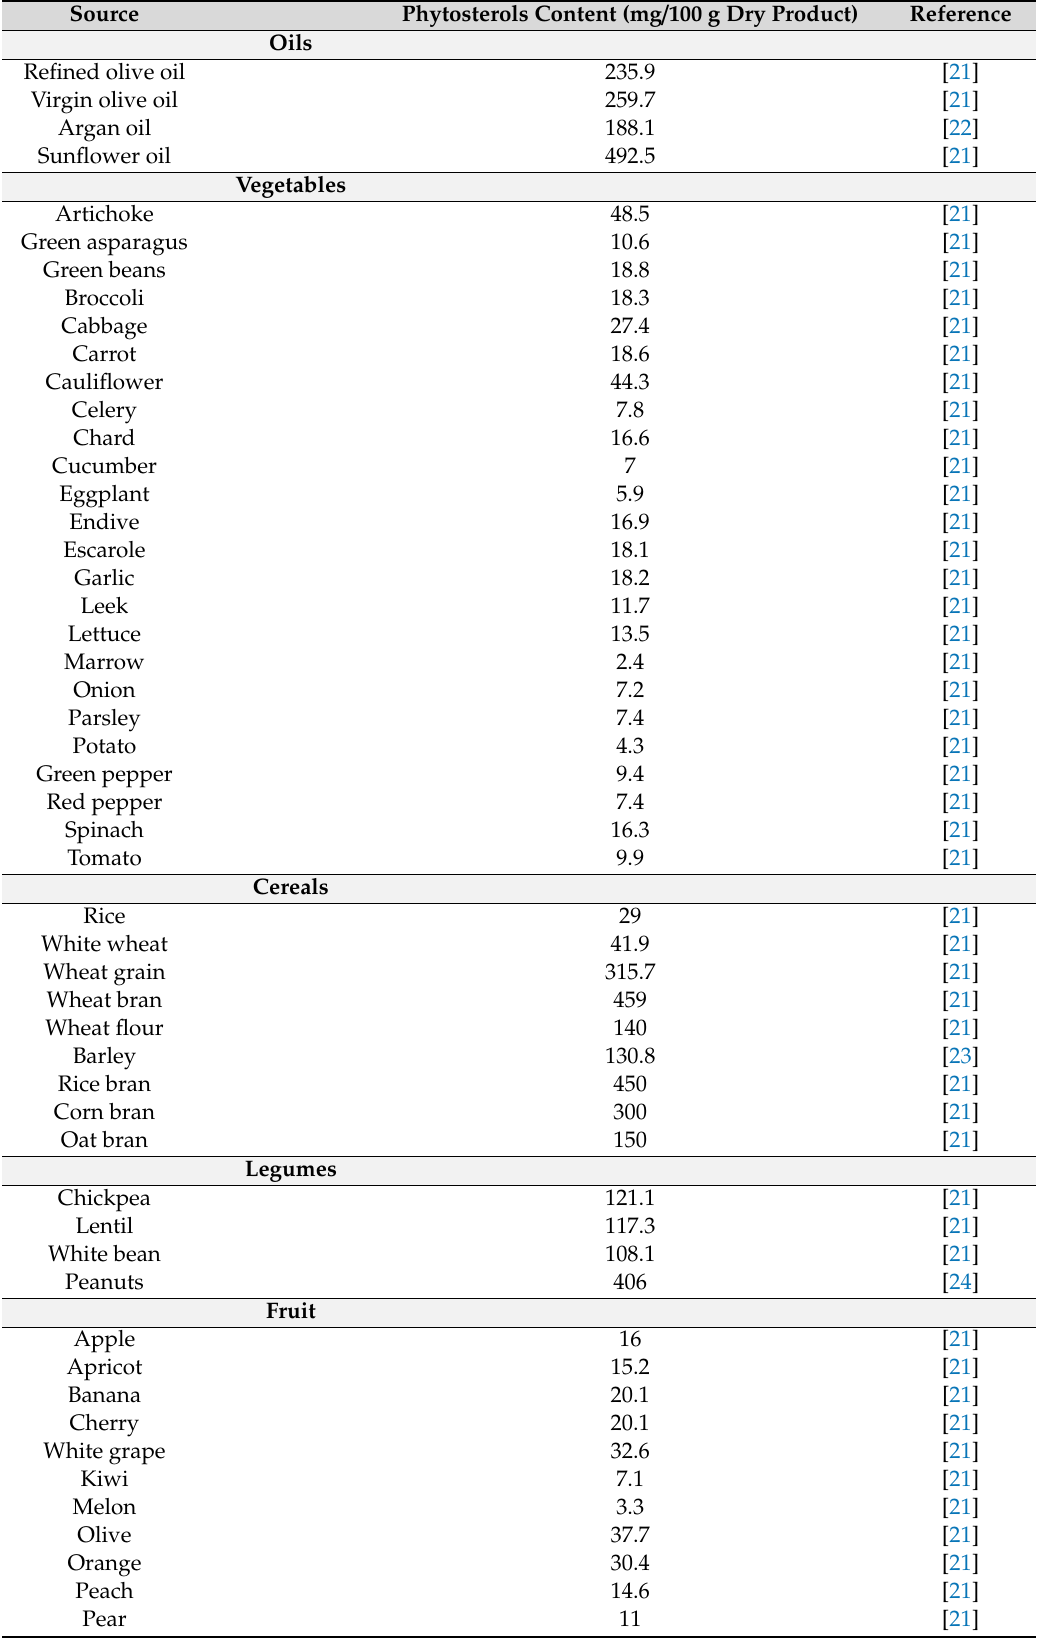
Table 1. Phytosterols’ food sources and their content, expressed as mg / 100 g of dry